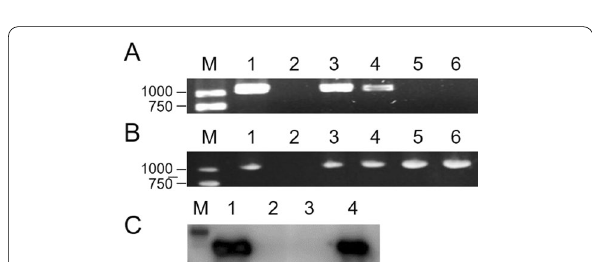
Fig.5 Detection of SMV-CP gene product. A Detection of SMV CP gene on grafted plants; M: DL 2000 bp DNA marker; 1: positive control (Jihuang 13 leaves inoculated with SC-8); 2: negative control (simulating inoculated leaves); 3: scion nf58 leaves after inoculation; 4: Stem of rootstock above the grafting site; 5: Stem of rootstock below the grafting site; 6: non-inoculated upper leaves of rootstock. B SMV- CP gene detection in rootstock when scion nf58 inoculated with N3 was pre-treated with 2-DDG. M:DL2000 bp DNA marker; 1: positive control (Jihuang 13 leaves inoculated with SC-8); 2: negative control (leaves inoculated with water); 3: upper leaves of Wuxing 2; 4: stem of rootstock above the grafting site; 5: stem of rootstock below the grafting site; 6: scion leaves after inoculation. C Western blotting detection of SMV CP. M: Easysee western marker; 1: Leaves of scion after inoculation with SMV; 2: Rootstock stem below the grafting site; 3: Uninoculated rootstock leaves above the grafting site; 4: Stem of rootstock above grafting